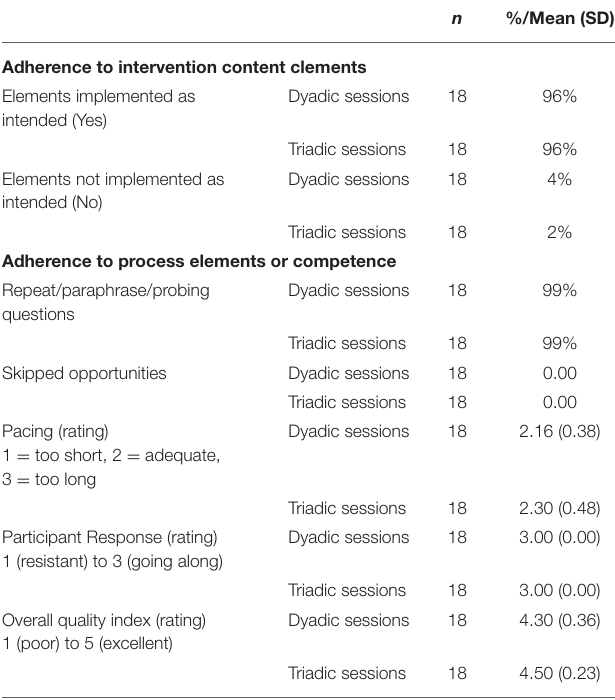
TABLE 6 | Facilitators’ compliance assessment by using ATTACH TM fidelity checklist.